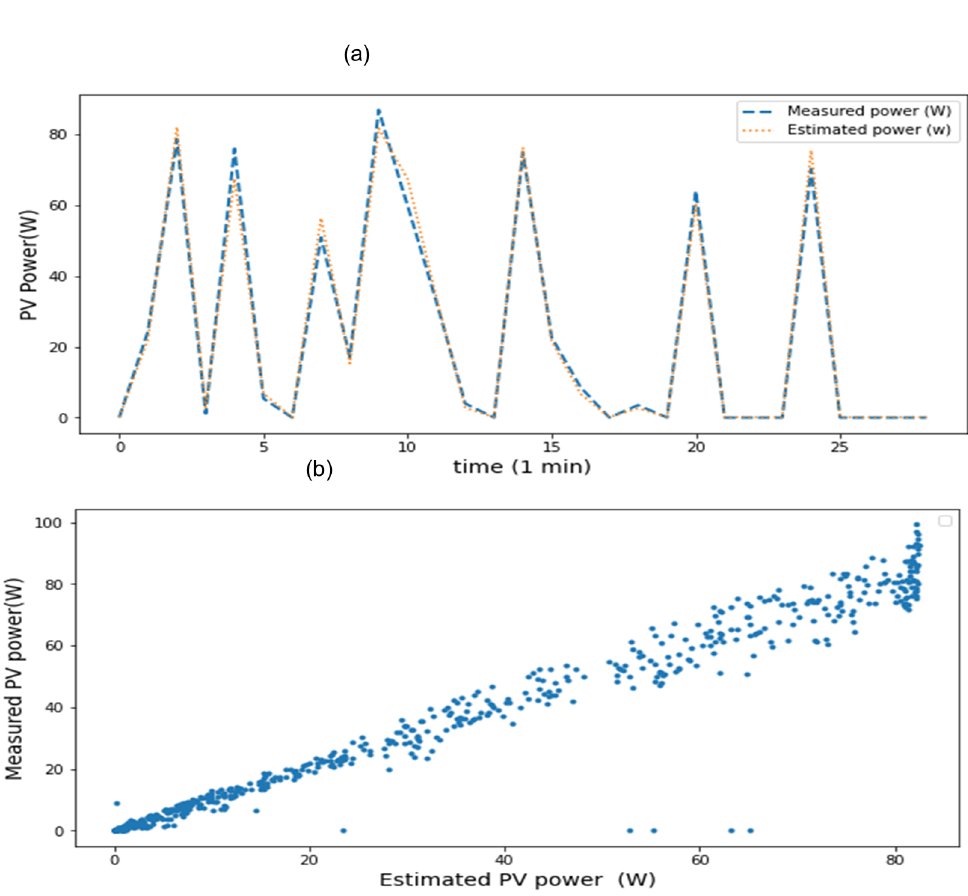
Figure 10. Simulation results: ( a ) measured versus predicted PV power and ( b ) scattered plot of the measured and predicted PV powers.